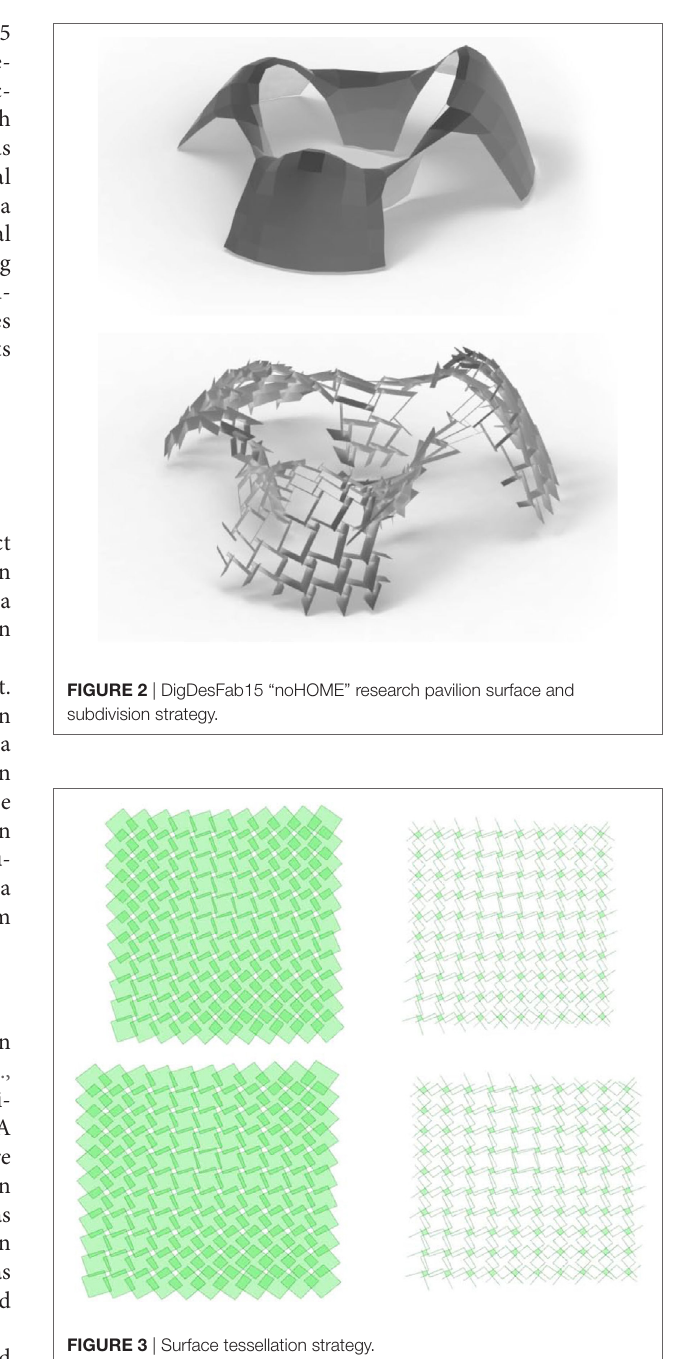
FIgURe 3 | Surface tessellation strategy.